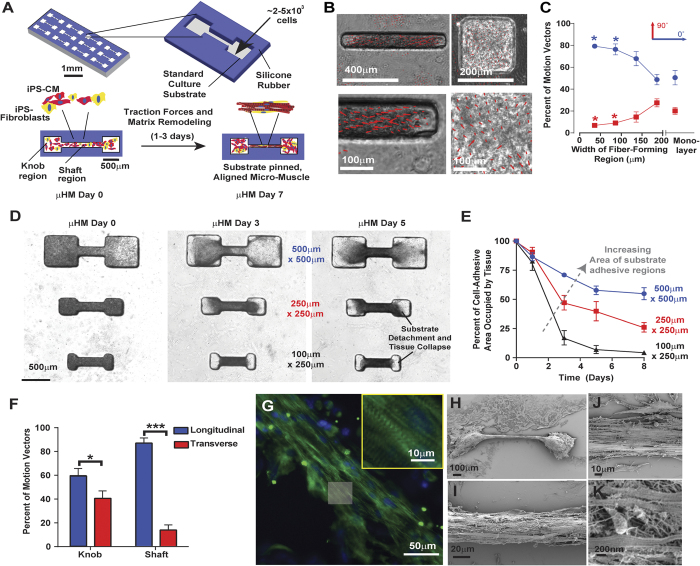
Simple stencil-based strategy to produce Micro-Heart Muscle.(A) Schematic describing strategy to produce Micro-Heart Muscle (μHM) arrays. Through-holes in stencils are seeded with a combination of iPS-CM (red) and fibroblasts (yellow), and the geometry of these regions generates a uniaxially-stressed, substrate-anchored tissue. (B) Representative images of iPS-CM and isogenic fibroblasts combined and seeded into (left) or square-shaped (right) through-holes. Red vectors quantify direction and magnitude of contractile motion during maximum contraction velocity (peak contractility). (C) Quantification of the direction of motion of all motion vectors, for tissue formed within rectangular through-holes with constant area (4 × 104 μm2) but varying width (*p < 0.05 compared to “no-pattern” condition). Direction was quantified via the percentage of vectors that were longitudinal (blue) versus transverse (red) to the long-axis of the rectangular through-hole. (D) Representative time-course images depicting assembly of substrate-anchored μHM, with cell-adhesive “knobs” connected by a shaft, and (E) quantification of μHM integrity, as measured by the relative area occupied by tissue within the cell-adhesive region of dogbone stencil patterns, for μHM formed with knobs of varying geometry. (F) Quantification of the percent of motion that is longitudinal versus transverse in the shaft and knob regions of μHM. (G) Representative whole-mount immunofluorescence staining for sarcomeric α-actinin (green, with Hoechst nuclear counterstain, blue) in a 2-week-old μHM. (H–K) Representative scanning electron micrographs depicting a substrate-anchored μHM, indicating assembly of fiber structures on the micron and sub-micron scales. Error bars: SEM, n = 5–6 (*p < 0.05, ***p < 10−5). Scale bars: B: 400 μm (top left); 200 μm (top right); 100 μm (bottom); D: 500 μm; G: 50 μm (inset: 10 μm); H: 100 μm; I: 20 μm; J: 10 μm; K: 200nm. Error bars are SEM, n = 5–6).